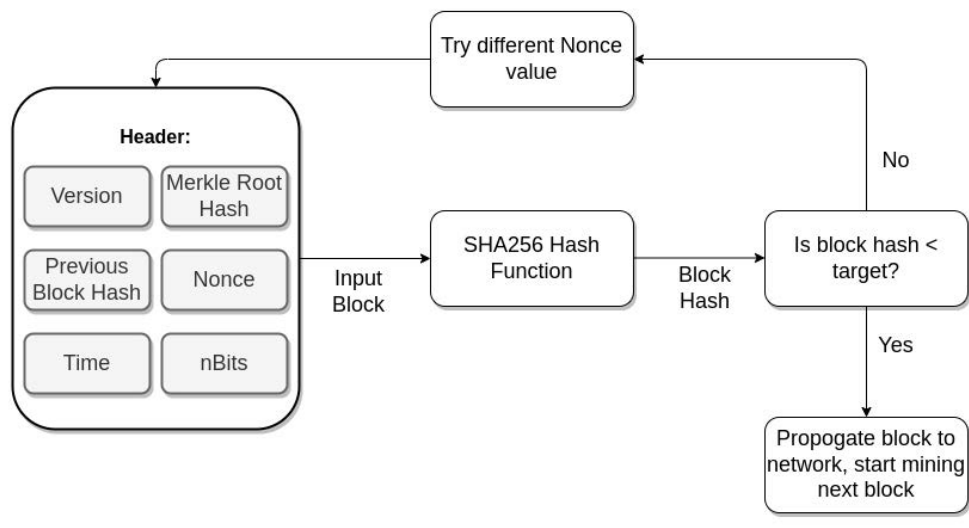
Figure 1. The process of mining on PoW